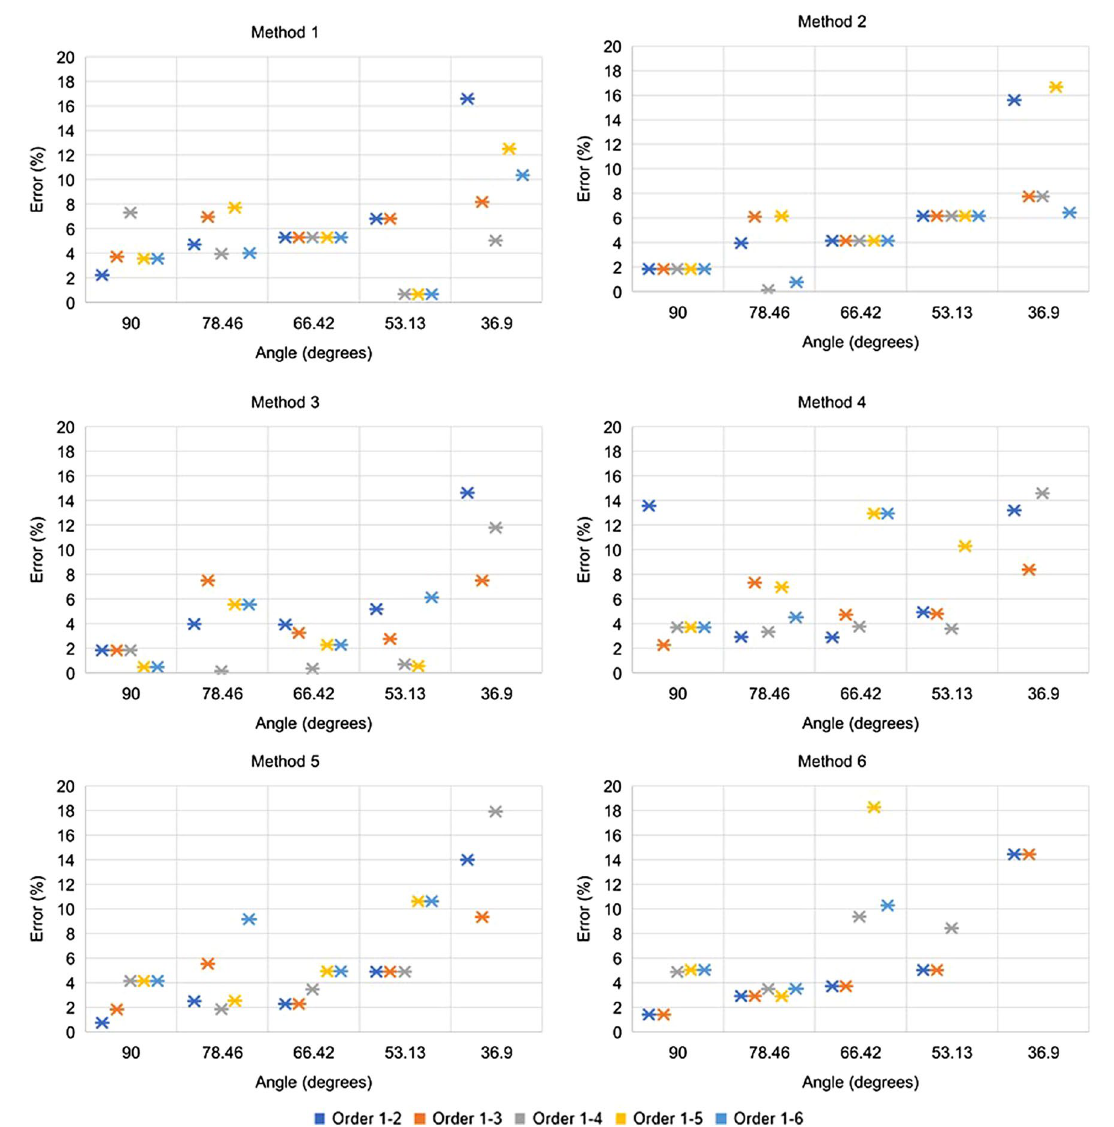
Fig. 5 Error percentage for five contact angles for all six